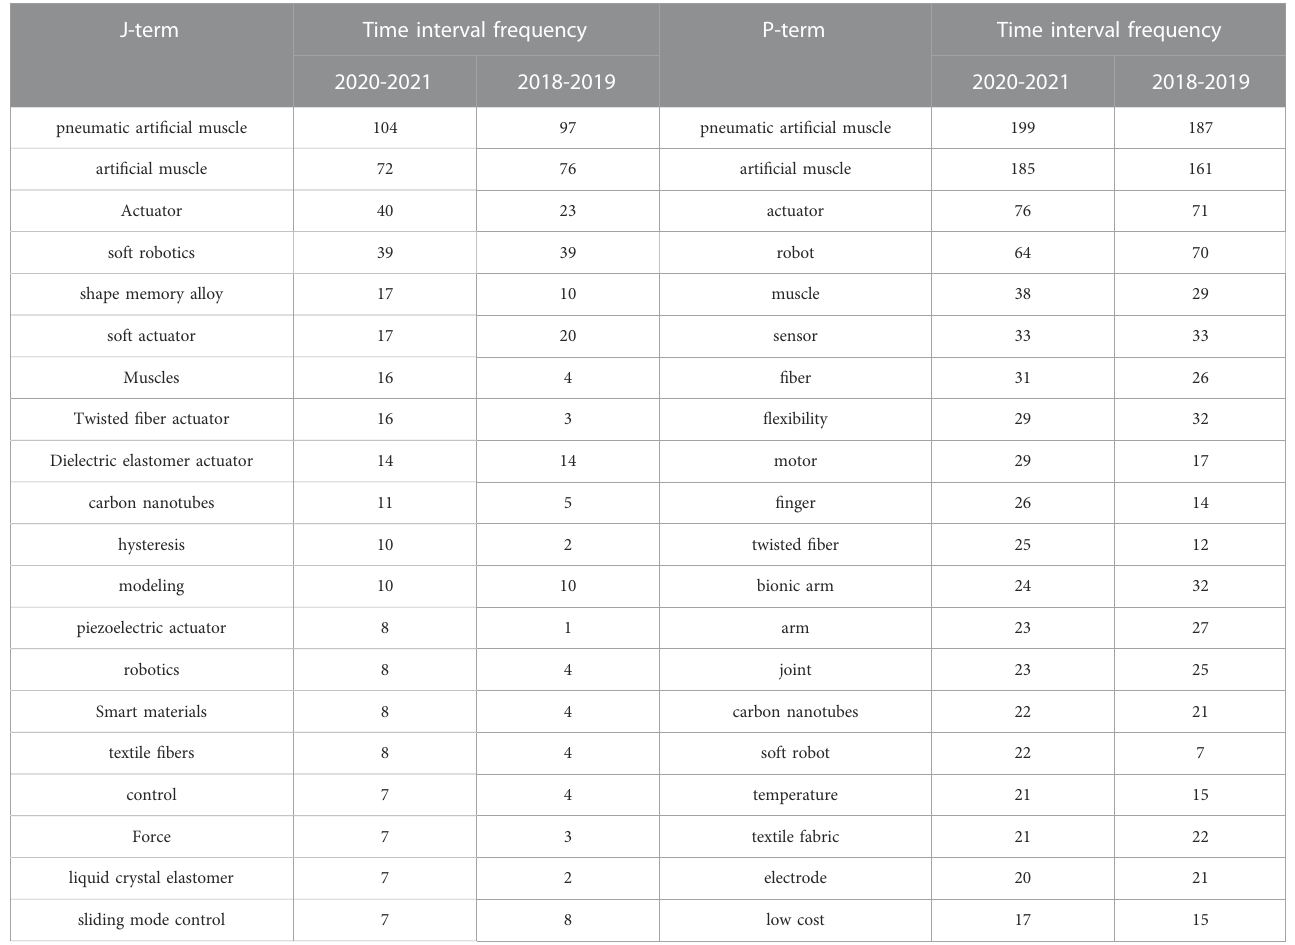
TABLE 7 Evolution of arti fi cial muscle terms since 2018.